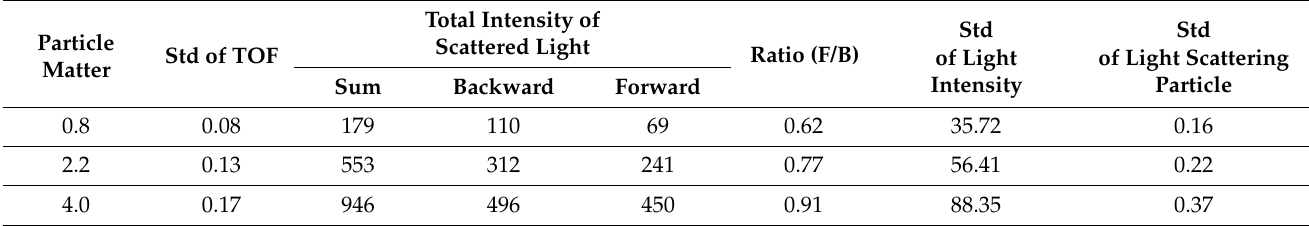
Table 3. Standard deviation of TOF and Intensity of PM0.8 \ PM2.2 \ PM4.